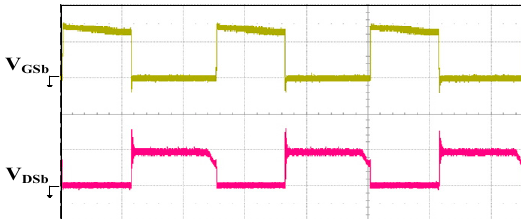
Figure 18. Experiment of voltage waveforms of S b (V GSb , V DSb ), V GSb , V DSb : 10 V/div, Time: 20 µs/div.